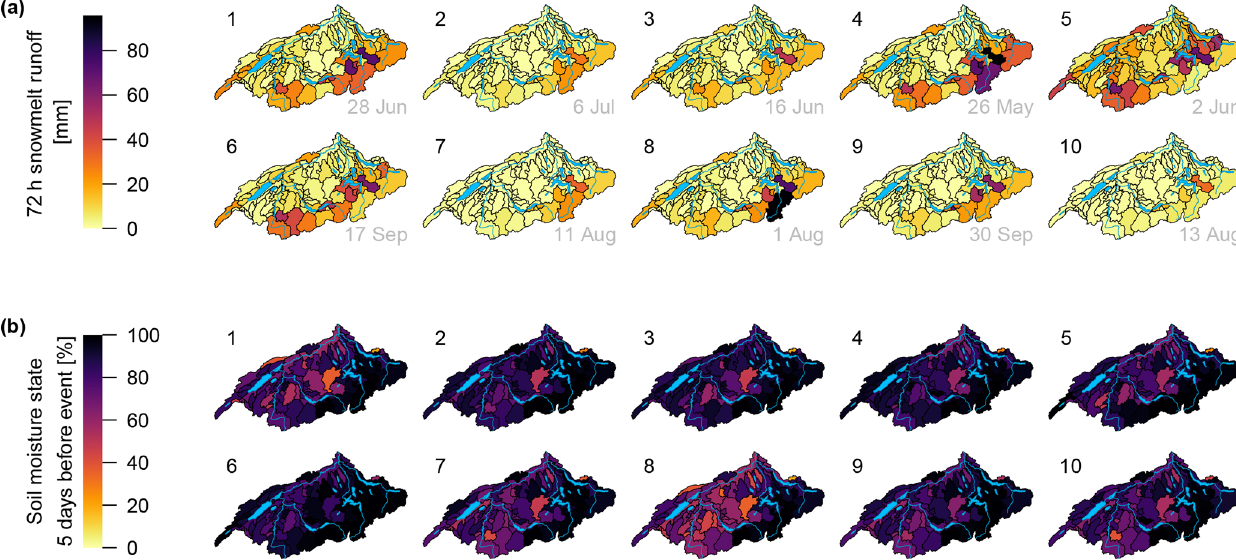
Figure 9. Patterns of snowmelt runoff (sum over the 72h preceding peak flow at the Aare River basin outlet) (a) and soil moisture storage (filling level relative to maximum storage available, 5d before peak flow at the Aare River basin outlet) (b) for the 10 largest peak flow events simulated at the outlet of the Aare River